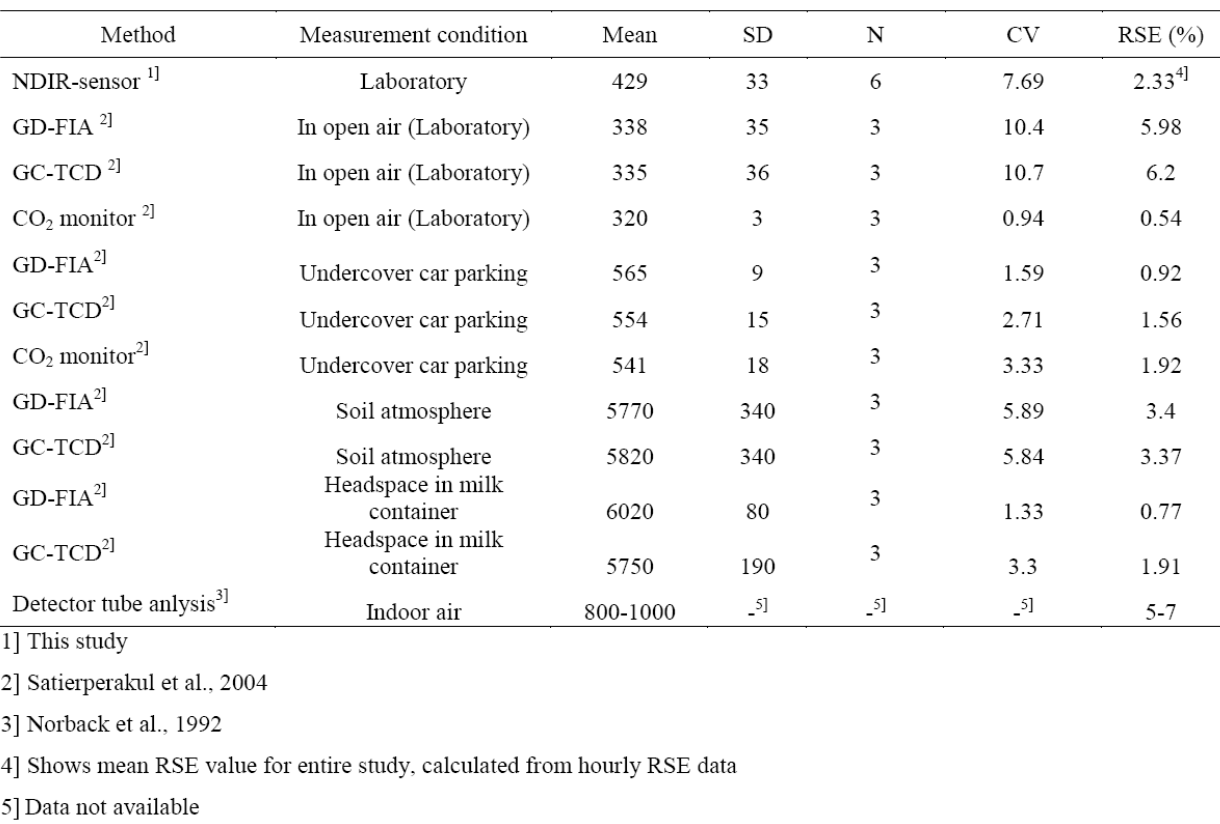
Table 5. A comparison of relative performance between different methods in the analysis of CO 2